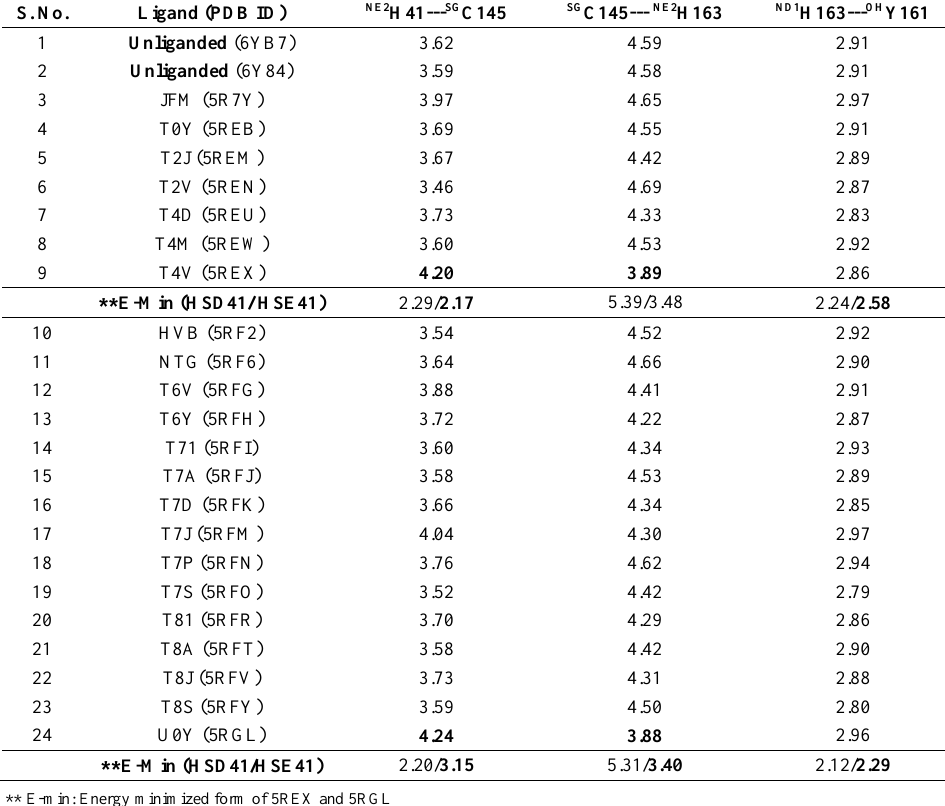
Table 1. The distances (Å) from His41 to Tyr161 through interactions of Cys145 and His163 residue in the crystal structure of Mpro protein. S. No. Ligand (PDB ID)